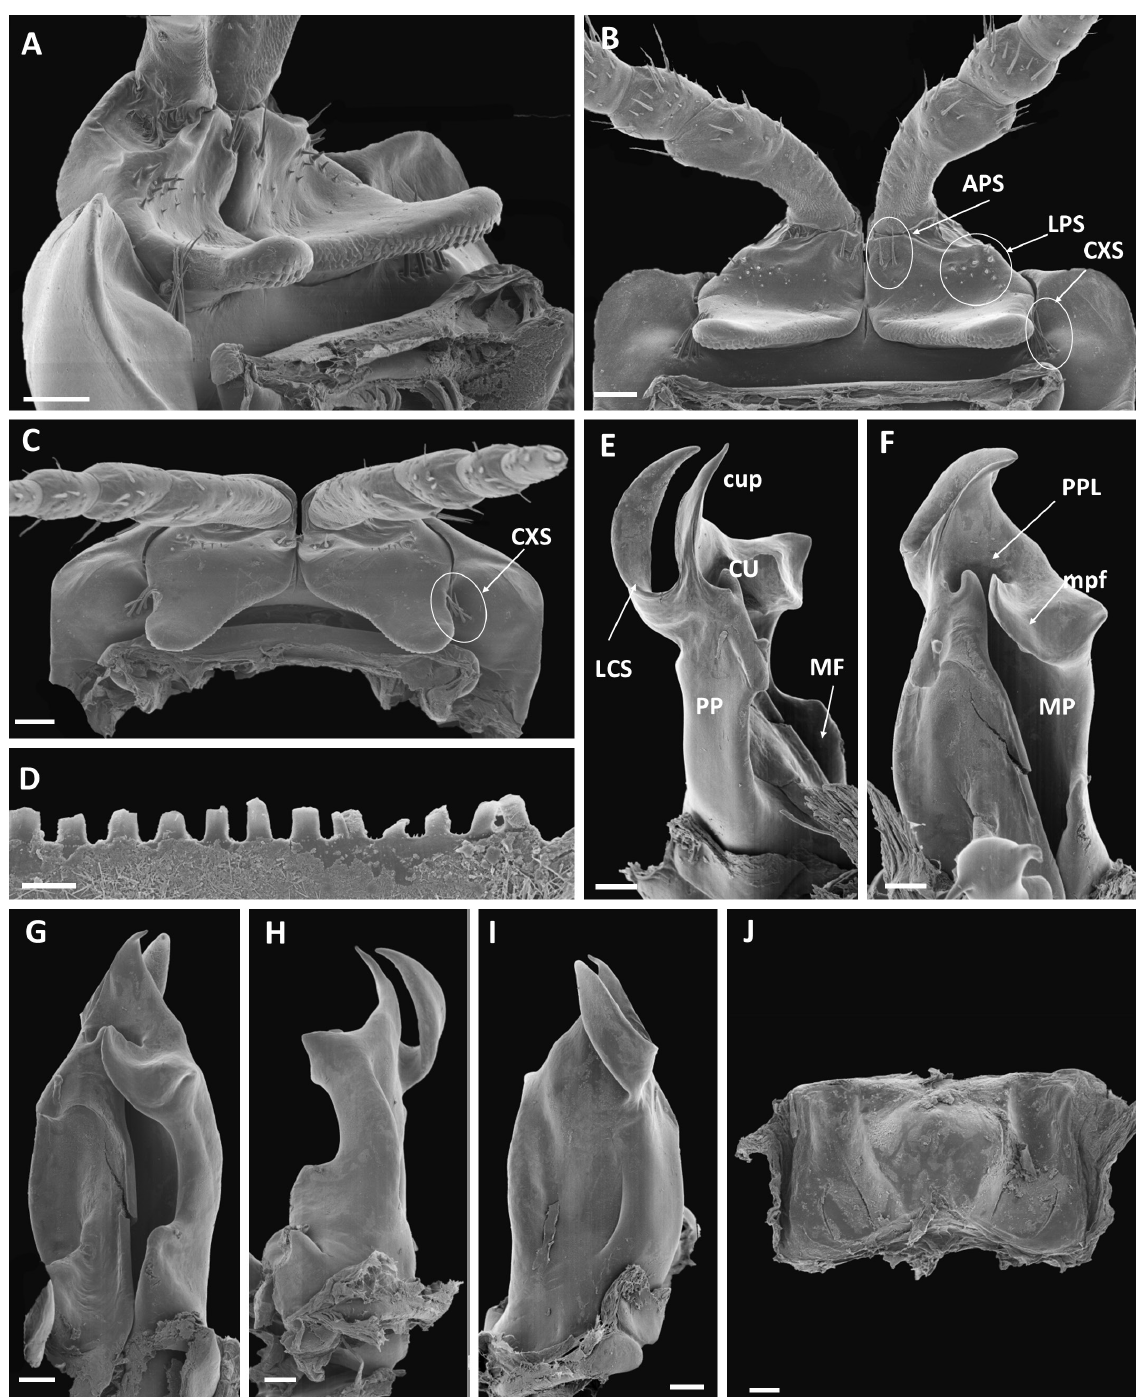
Fig. 71. Xystopyge minnae sp. nov., holotype, ♂ (NHMD 621772). A–C . First pair of legs. A. Sublateral view. B. Anterior view. C. Ventral view. D . Midbody dorsal limbus. E–I . Left gonopod coxa. E. Anterior view. F. Anterior-mesal view. G. Mesal view. H. Posterior view. I. Lateral view. J . Sternum 9. Abbreviations: APS = mesapical prefemoral setae; CU = cucullus; cup = cucullar process; CXS = coxosternal setae; LCS = lateral coxal spine; LPS = lateral prefemoral setae/sensilla; MF = metaplical flange; MP = metaplica; mpf = metaplical distal flange; PP = proplica; PPL proplical lobe. Scale bars: A–C, E–J = 0.1 mm; D = 0.01